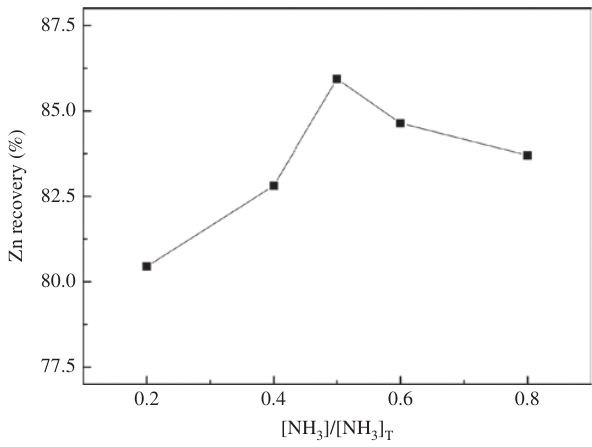
Figure 7: Effect of different ammonia/ammonium ratios on leaching rate of zinc. Note: [NH concentration of ammonia, the concentration of ammonium, the total ammonia concentrations of ammonia and ammonium, and ammonia/ammonium ratio, respectively.